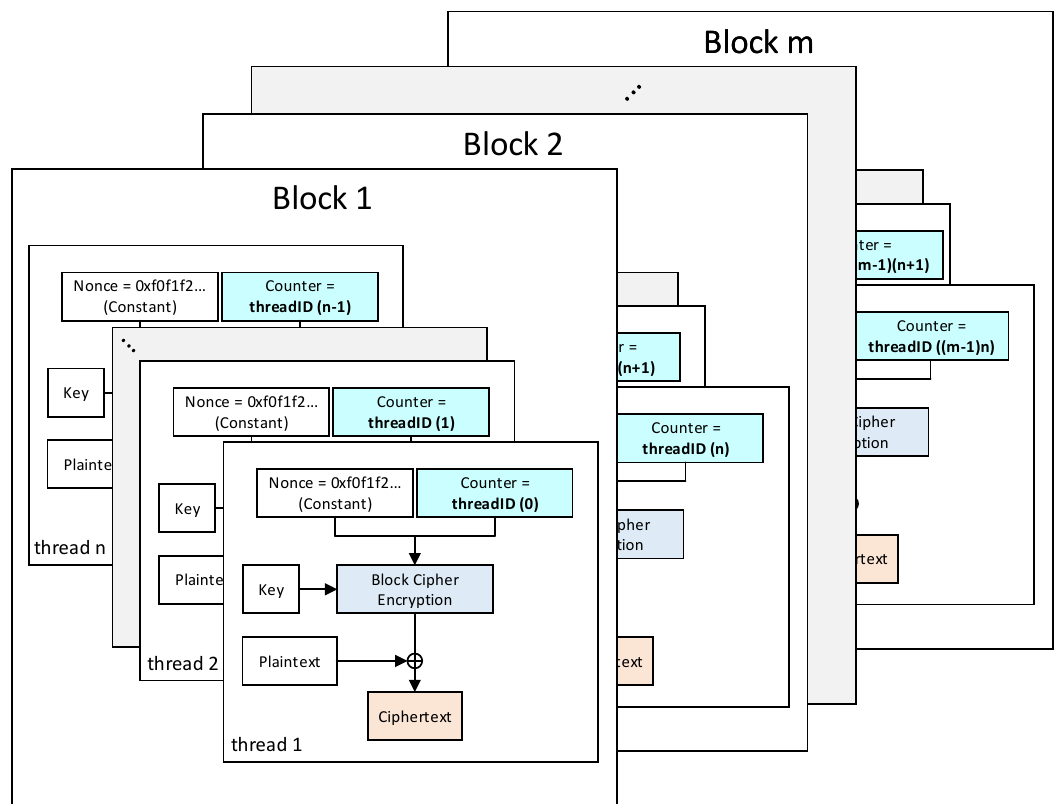
Figure 8. Parallel CTR encryption on GPU